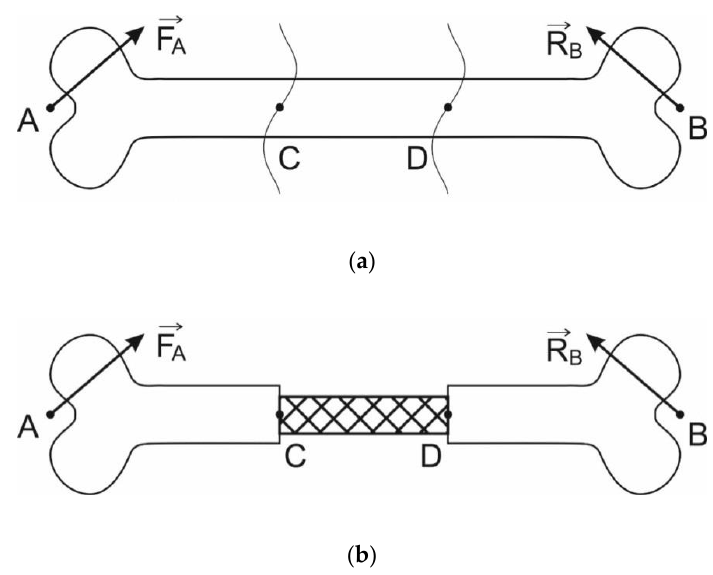
Figure 1. Scheme of long bone before ( a ) and after mounting lattice implant ( b ). Force F applied at point A, force R applied at point B. Section CD should be replaced by endoprosthesis.